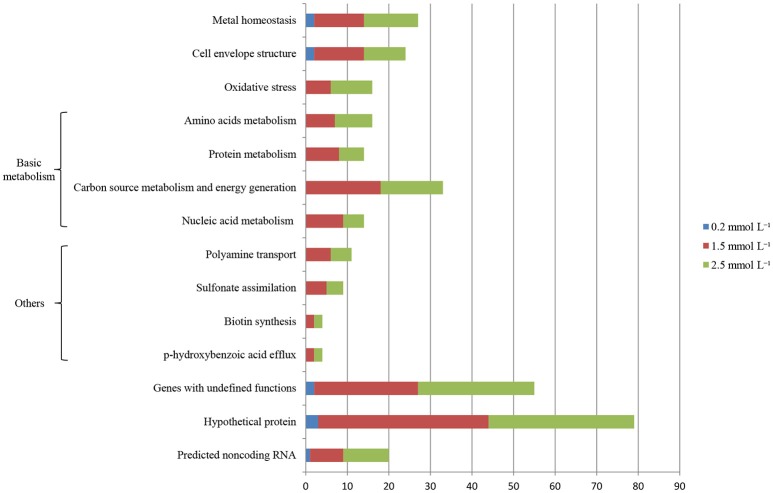
Distribution of genes whose transcription levels were strongly affected by zinc treatment. The top 11 functional categories affected by zinc are illustrated. Genes involved in polyamine transport, p-hydroxybenzoic acid efflux, biotin synthesis, and sulfonate assimilation are sorted into an artificial group designed as “others”.